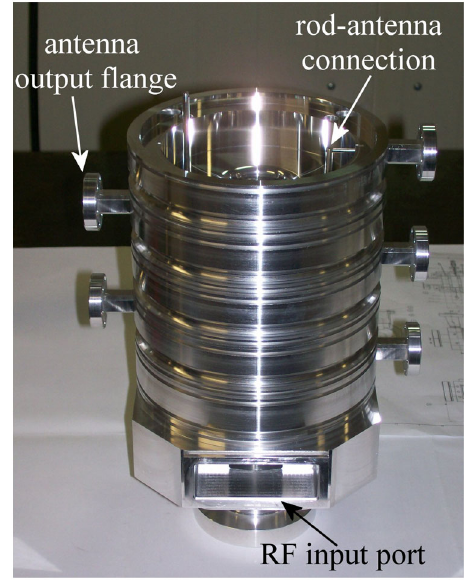
FIG. 15. Assembled RFD cells.